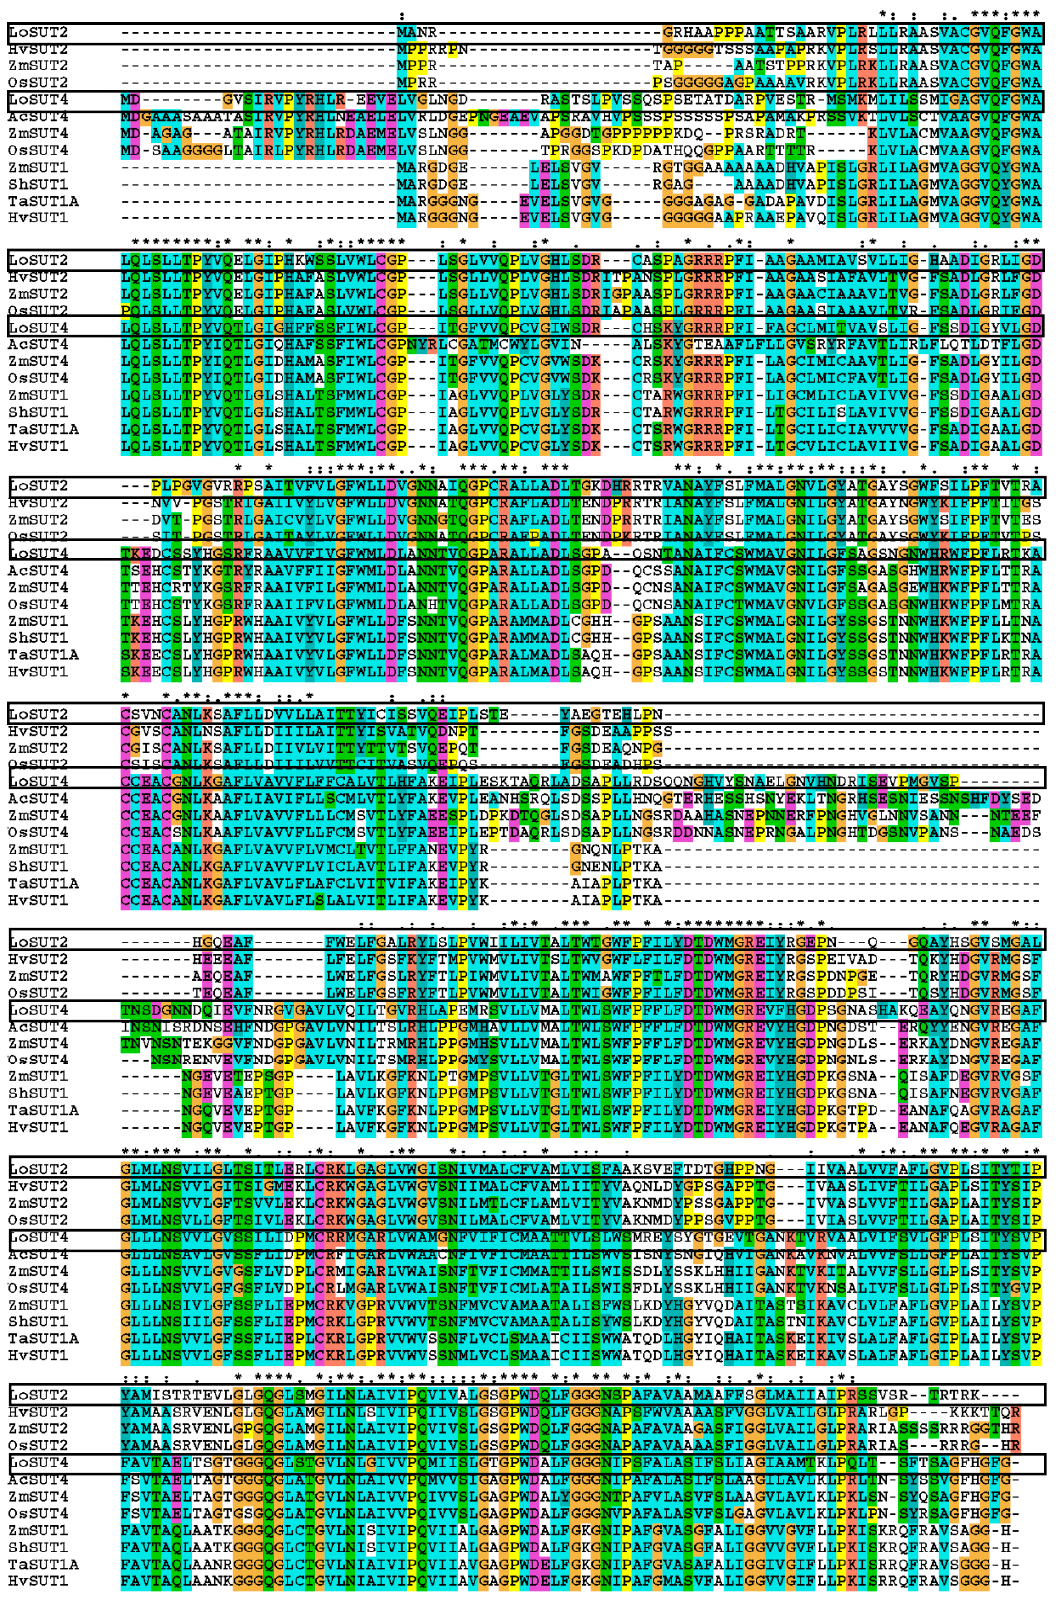
Figure 11. Comparison of the deduced amino acid sequence of LoSUT2 and LoSUT4 with its homologs. The black box represents the location of LoSUT genes. Amino acid residues of different kinds are shaded in different colors to show the similarity of the sequences.